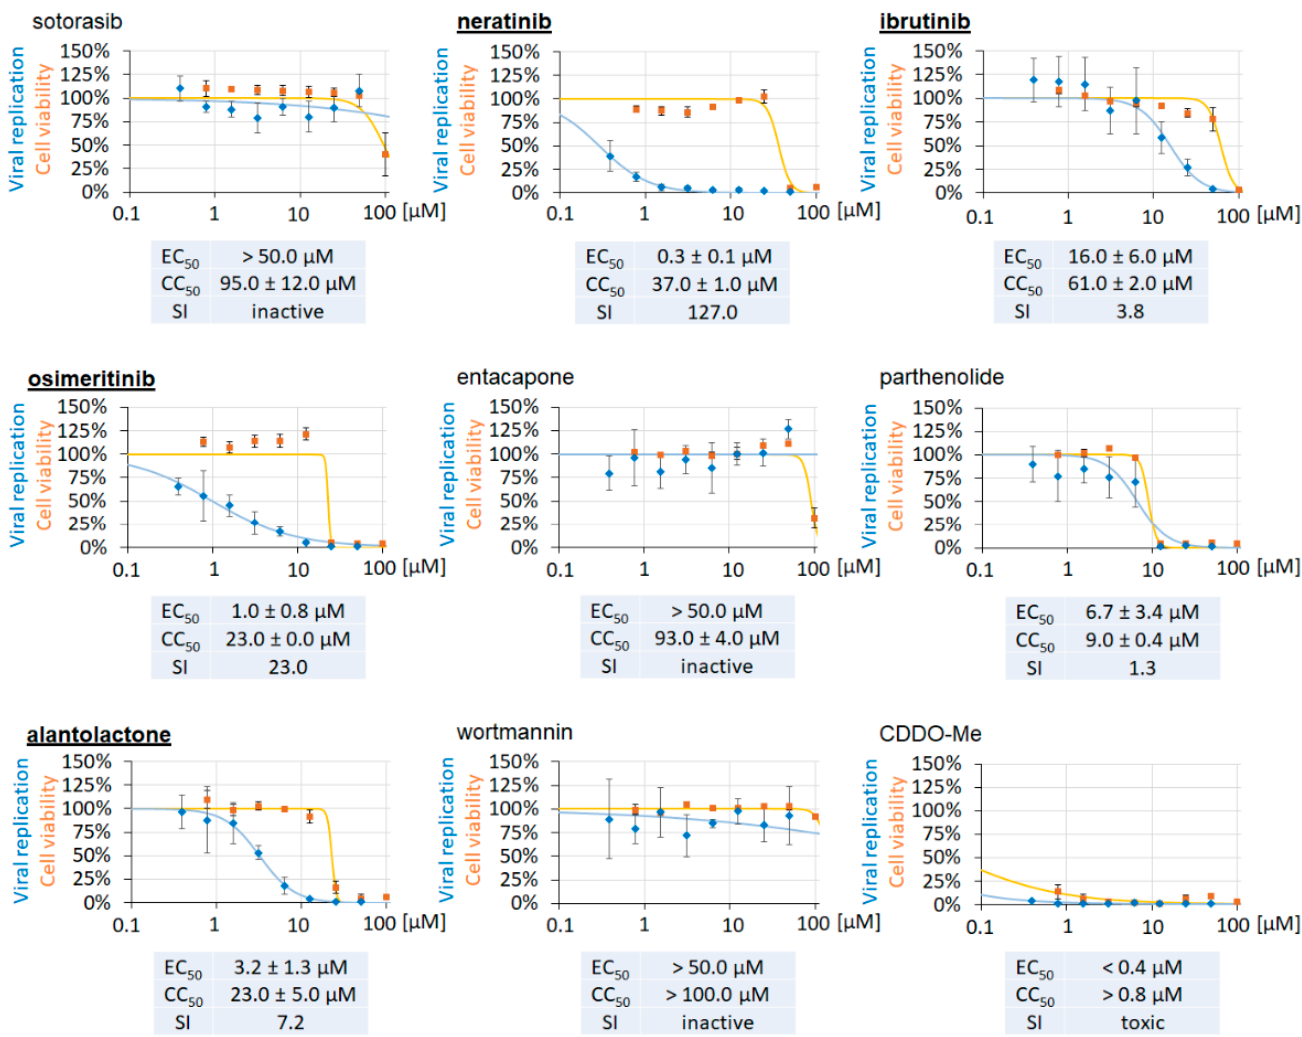
Figure 7. Antiviral activity of clinically relevant warhead compounds. HCMV AD169-GFP-infected HFFs were treated with compounds to analyze their antiviral activity via quantitation of the GFP reporter signal at 7 d p.i. In parallel, cell viability was assessed using Neutral Red staining of uninfected, compound-treated cells. Mean values ± SDs are given; EC 50 , CC 50 and SI values are indicated below the curves. Hit compounds are marked as underlined in